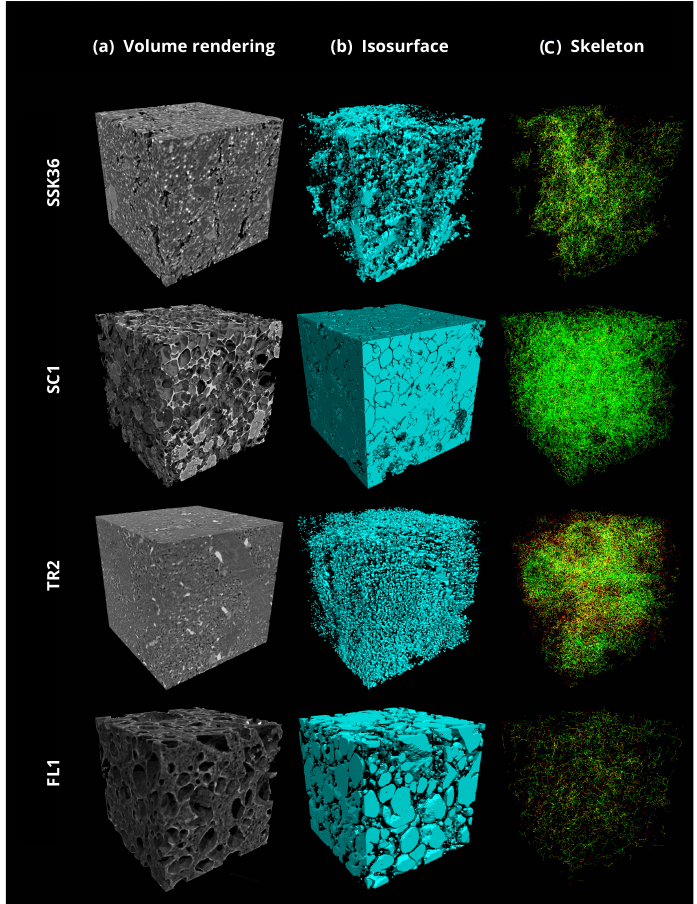
Figure 6. Results of microtomographic reconstruction and image processing on the same volume of interest (VOI, size = 700 × 700 × 700 voxels) for the four investigated samples. ( a ) 3D renderings of raw data as obtained after tomographic reconstructed. ( b ) Corresponding isosurface renderings of the segmented vesicle phase. ( c ) Results of the skeletonisation analysis of the vesicle network representing node-to-node (green), node-to-end (yellow) and end-to-end (red) branches. The sample used in the current case study is an Ottawa sand in brine at 0 degrees